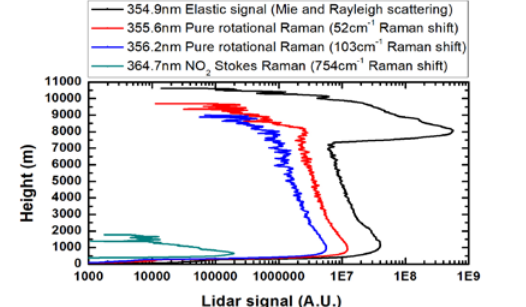
Figure 4. Elastic and Raman lidar signals at 1726 UTC on 3 November 2017.